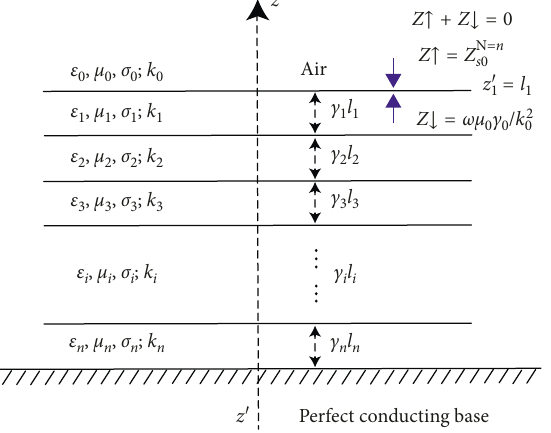
Figure 3: The N -layered model with the bottom half-space as conducting.